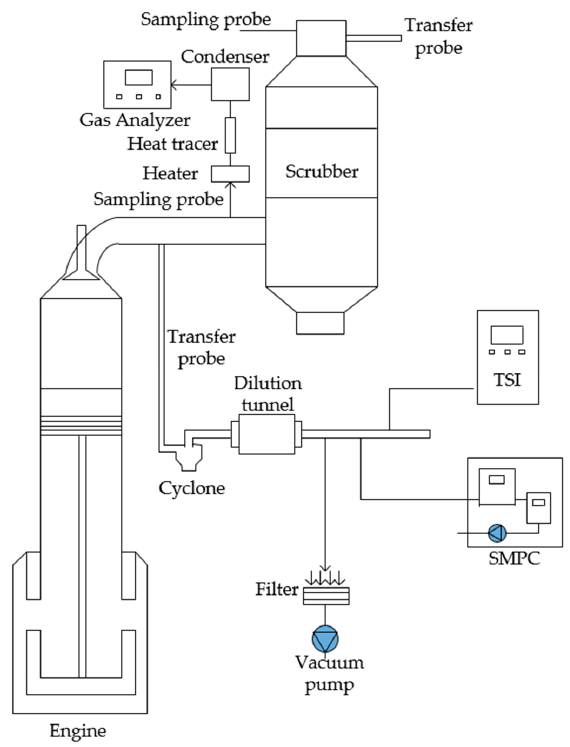
Figure 1. Principle diagram schematic of engine test system.